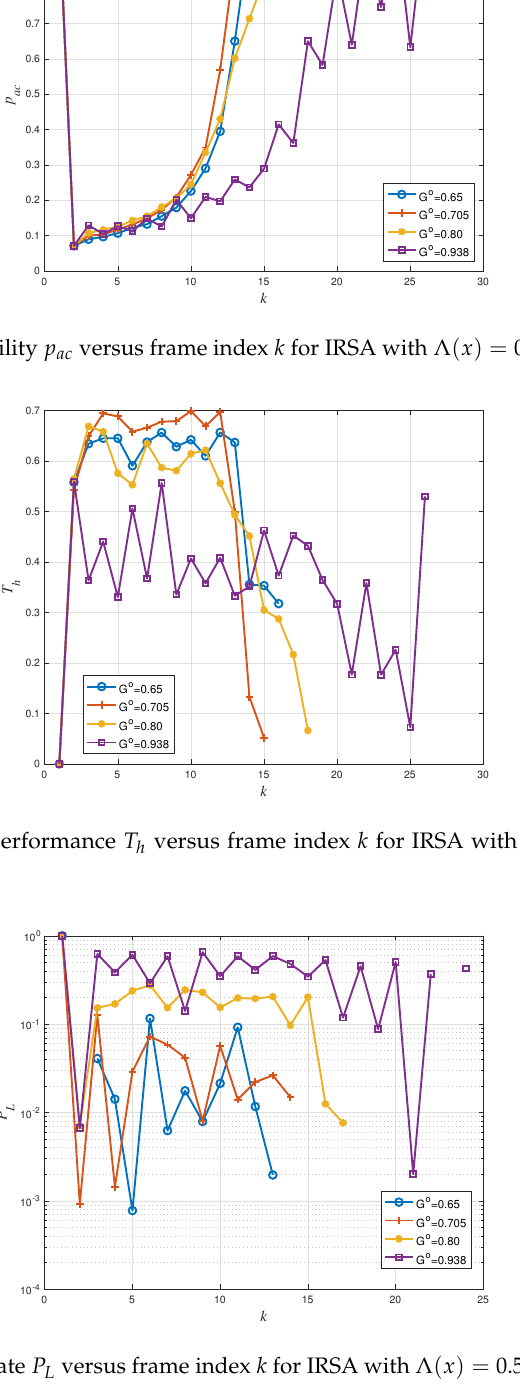
Figure 8. Packet loss rate P L versus frame index k for IRSA with Λ ( x ) = 0.5 x 2 + 0.28 x 3 + 0.22 x 8